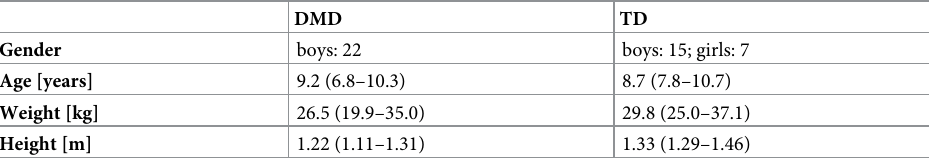
Table 1. Subject information of the children with DMD and TD children.